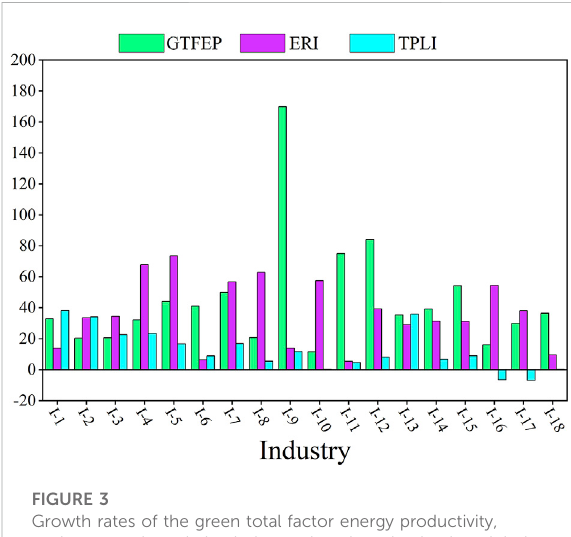
FIGURE 3 Growth rates of the green total factor energy productivity, environmental regulation index, and total production length index for the Chinese manufacturing industry (2000 – 2014).